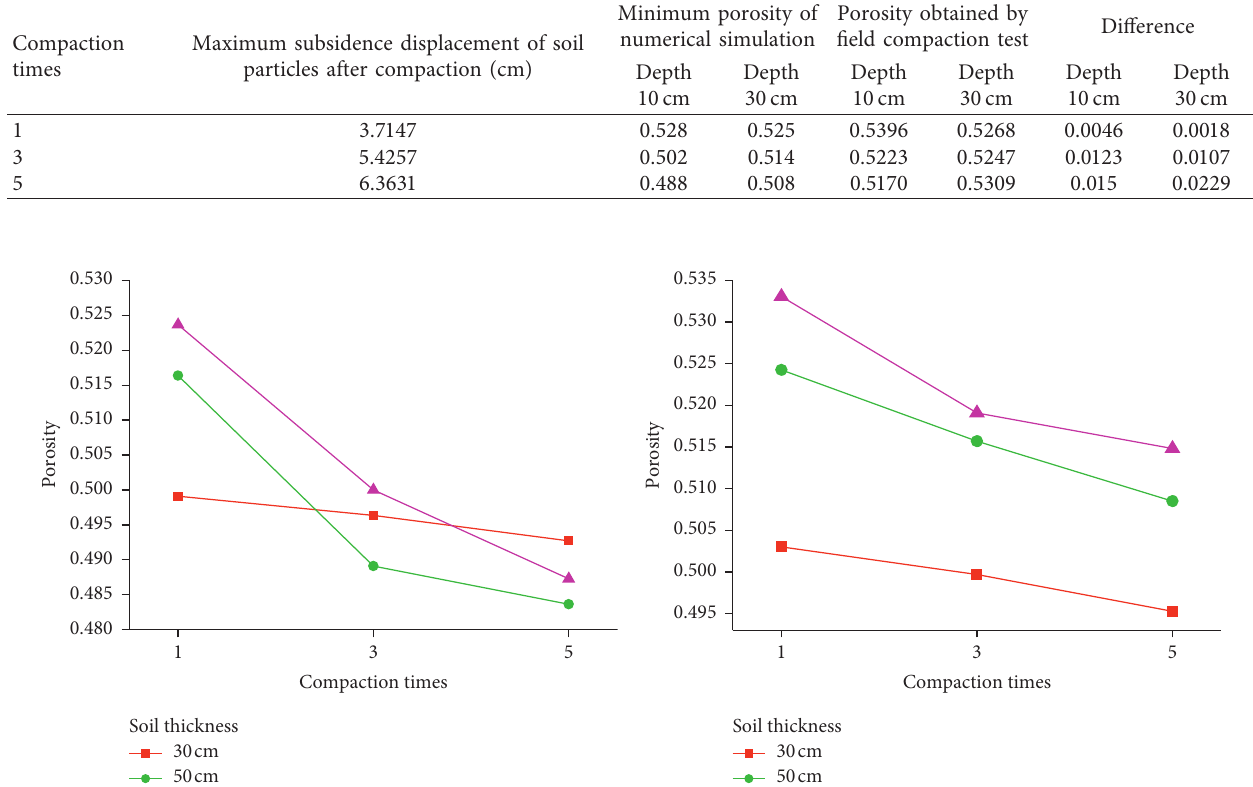
Table 8: Numerical simulation results for soil thickness 70cm.